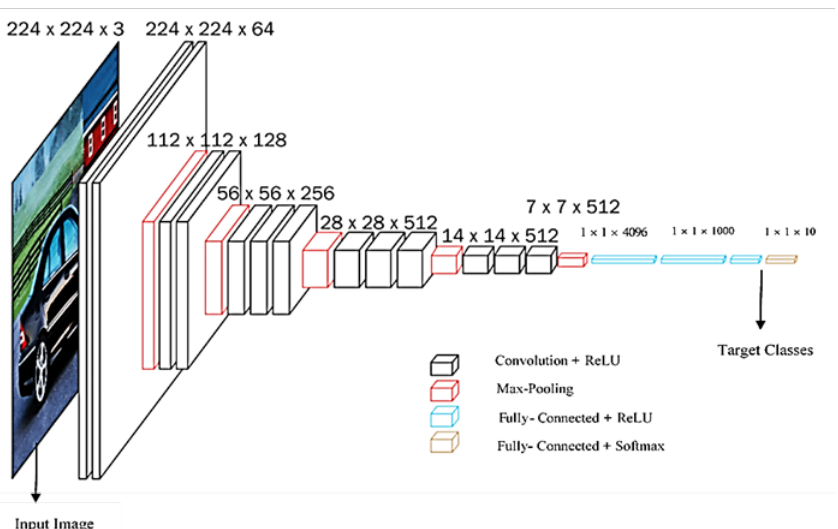
Figure 1. Schematic representation for determining the scattering image pattern.